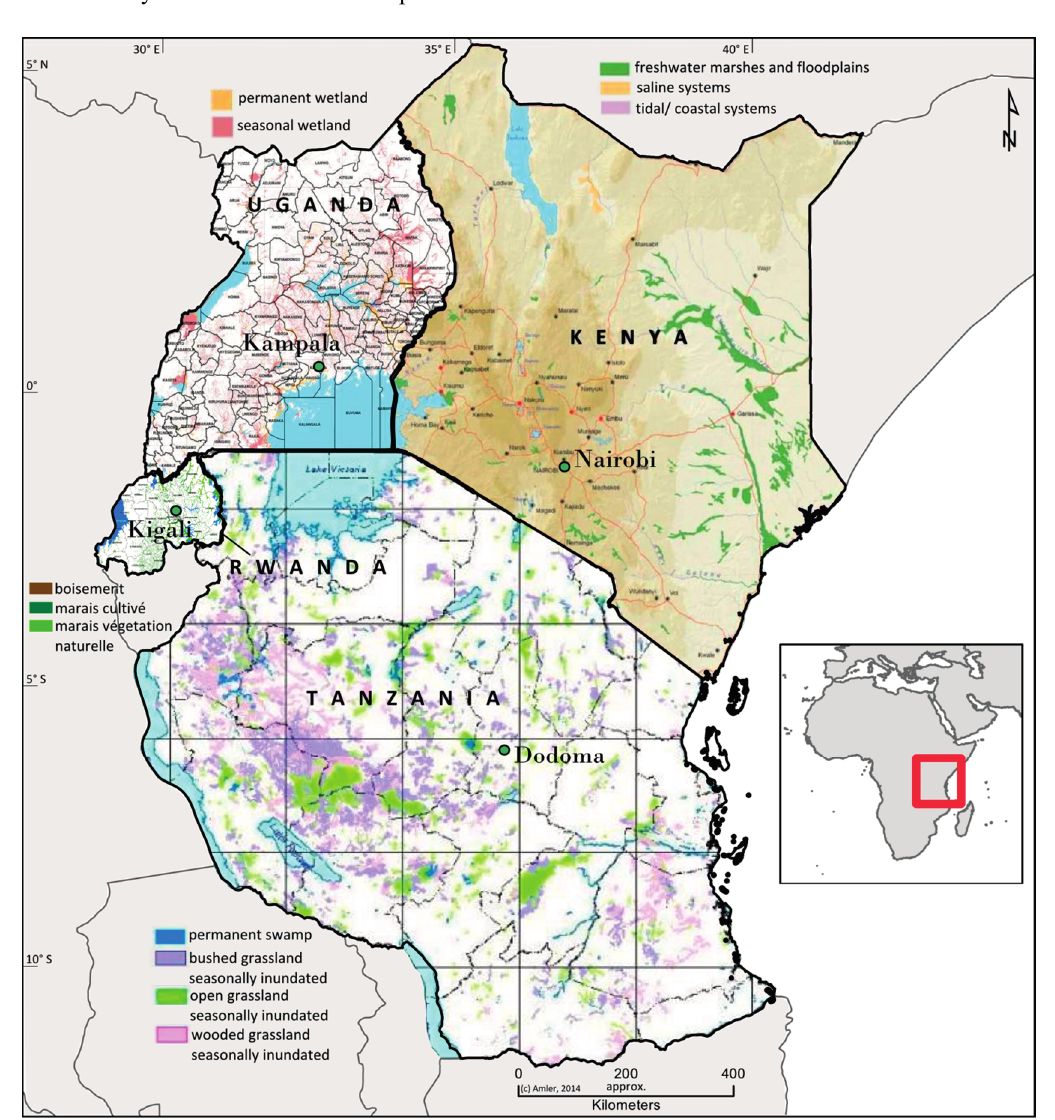
Figure 4. Mosaic of national wetland maps for the East African region showing different data sources and compilations for each country (shaded cells in Table 5)